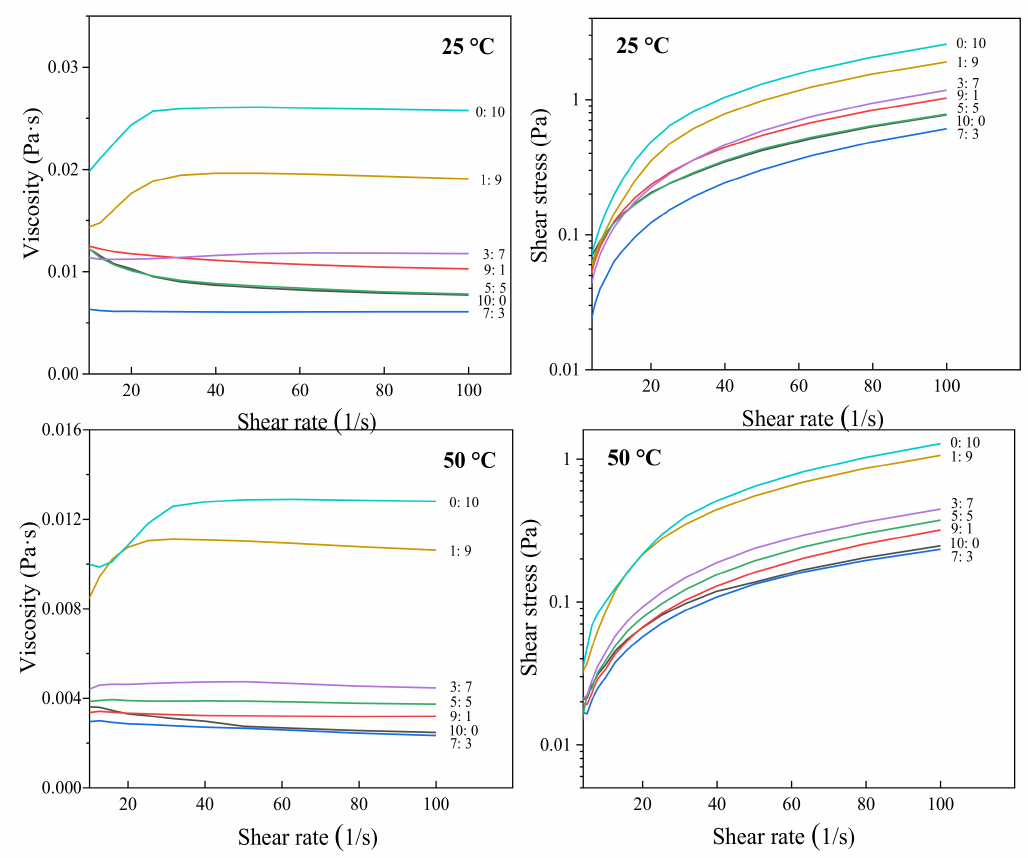
Figure 2. Shear rheological curve of capsaicin emulsion. The labels 10:0, 9:1, 7:3, 5:5, 7, 1:9, and 0:10 represent the ratio of whey protein to citrate mung bean starch